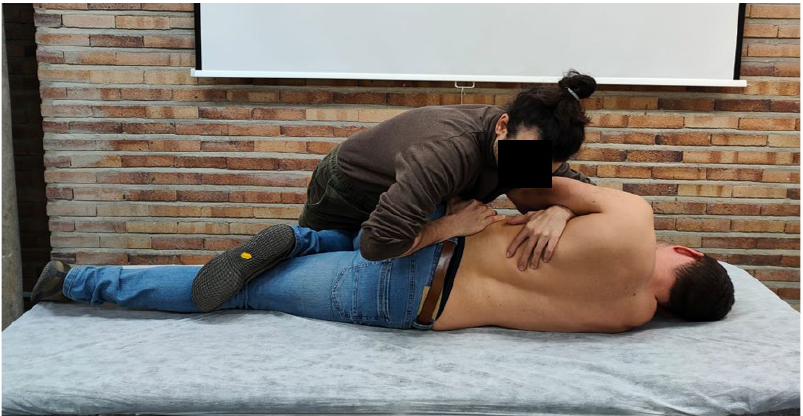
Figure 1. Motor task of rotational lumbar manipulation technique.